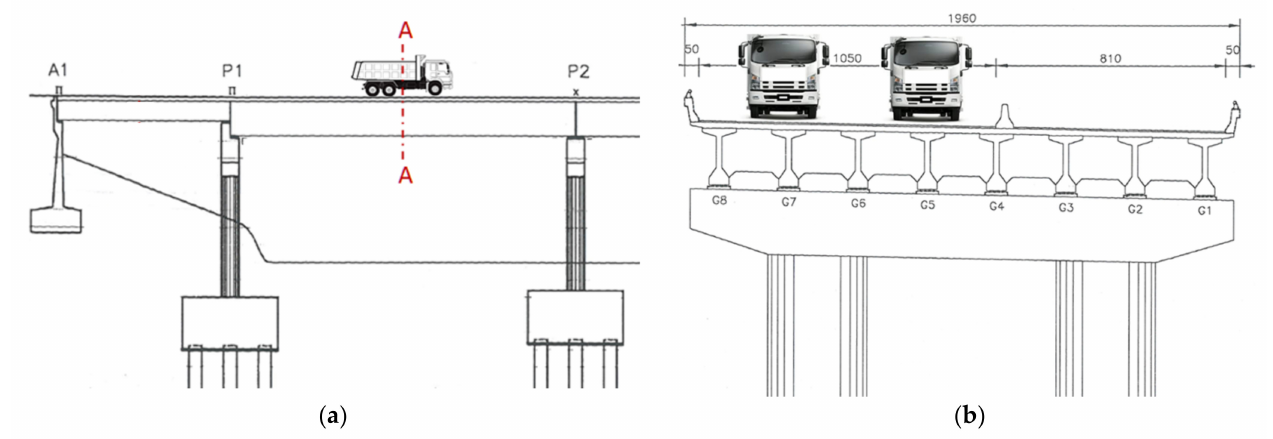
Figure 2. Schematic of the static test: ( a ) elevated view; ( b ) section A-A view.